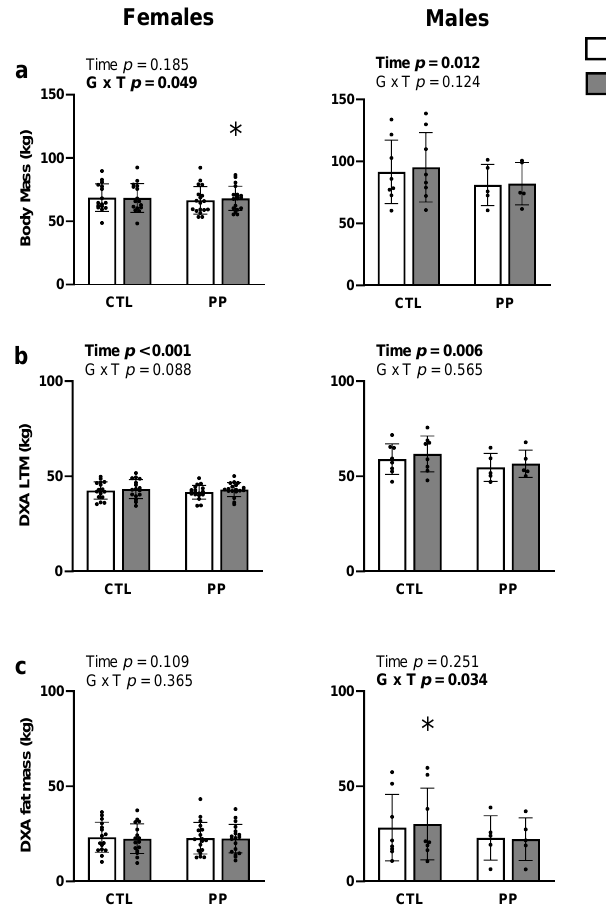
Figure 4. Body composition adaptations. Data include body mass ( a ), DXA-derived lean/soft tissue mass ( b ), and DXA-derived fat mass ( c ). All data are presented as mean ± standard deviation values. Abbreviations: PP, peanut protein group; CTL, control group. Symbols: •, indicates individual respondent data; *, indicates increase ( p < 0.05) within supplementation group from pre- to post-intervention.